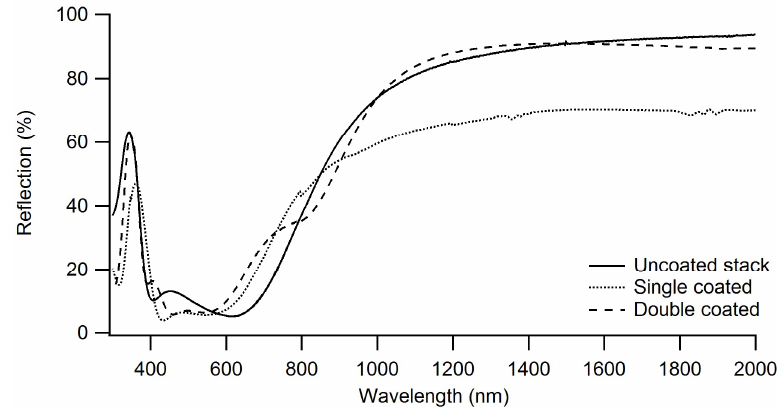
Figure 11. Reflection spectra of the uncoated stack, single coated window film, and double coated window film. The double coated is more reflective than single coated film at higher wavelengths.